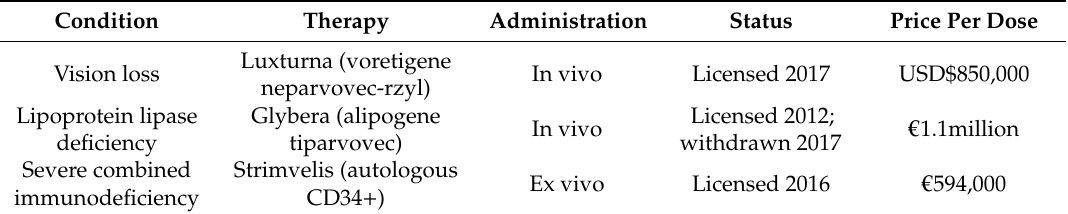
Table 1. Examples of Licenced Gene